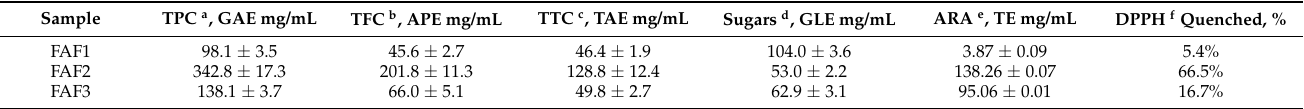
Table 2. Content of total phenolics, flavonoids, tannins, sugars, and DPPH free radical scavenging activity of Matricaria recutita white ray floret supercritical fluid extracts in